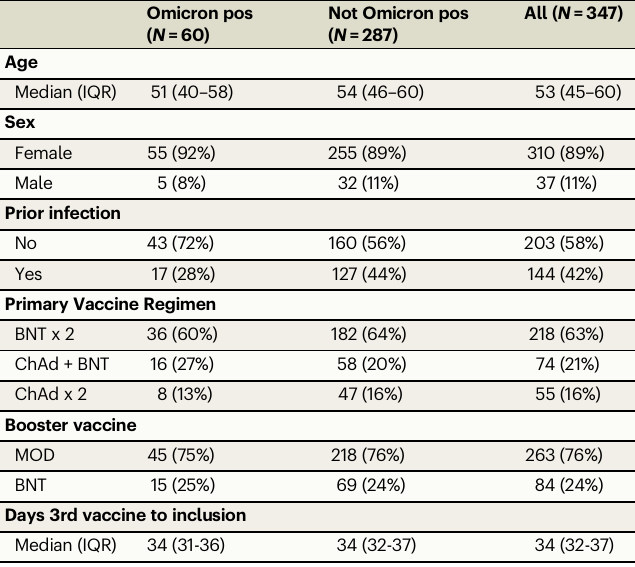
Table 1 | Demographics, frequency of prior SARS-CoV-2 infection and vaccine regimen of study cohort Omicron pos ( N